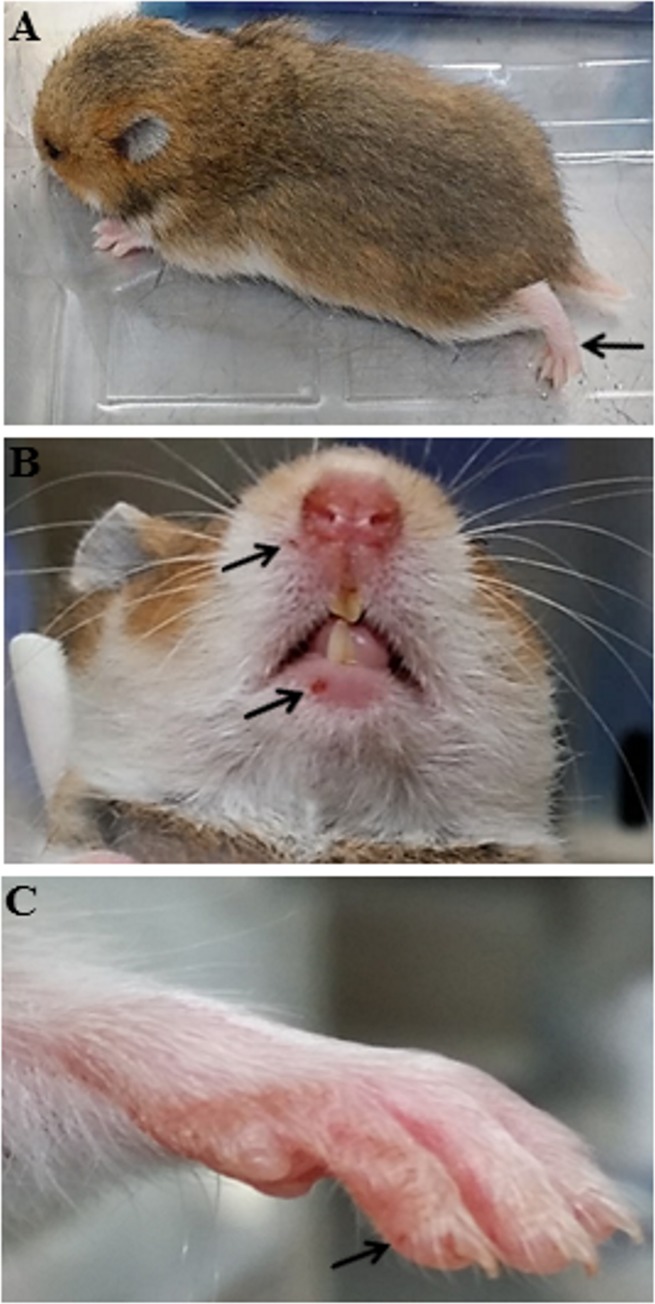
Infected hamster showing hind limb paralysis at day 4 post infection (A, arrow).Lesions on the lip (B, arrows) and paw (C, arrow) were observed in some animals.